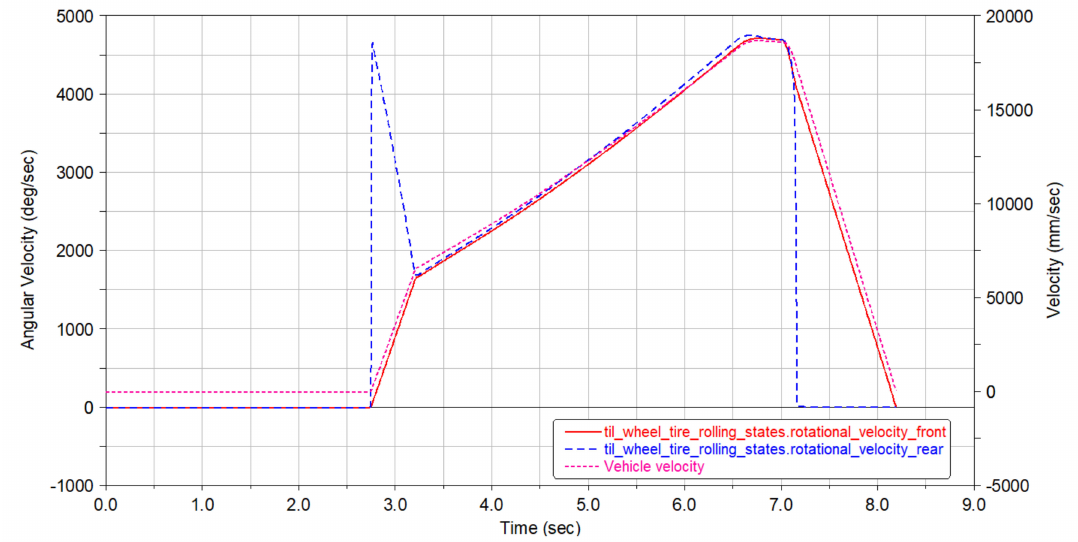
Figure 10. Brake Test-Baseline set-up.